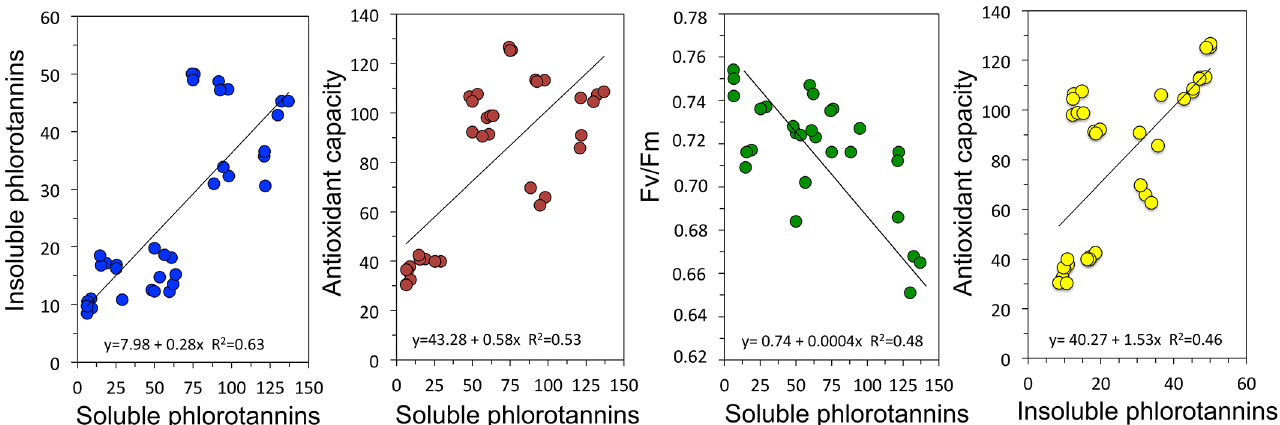
Fig 9. Relationship between different physiological variables determined in four species of endemic Antarctic brown algae collected at three different depths.